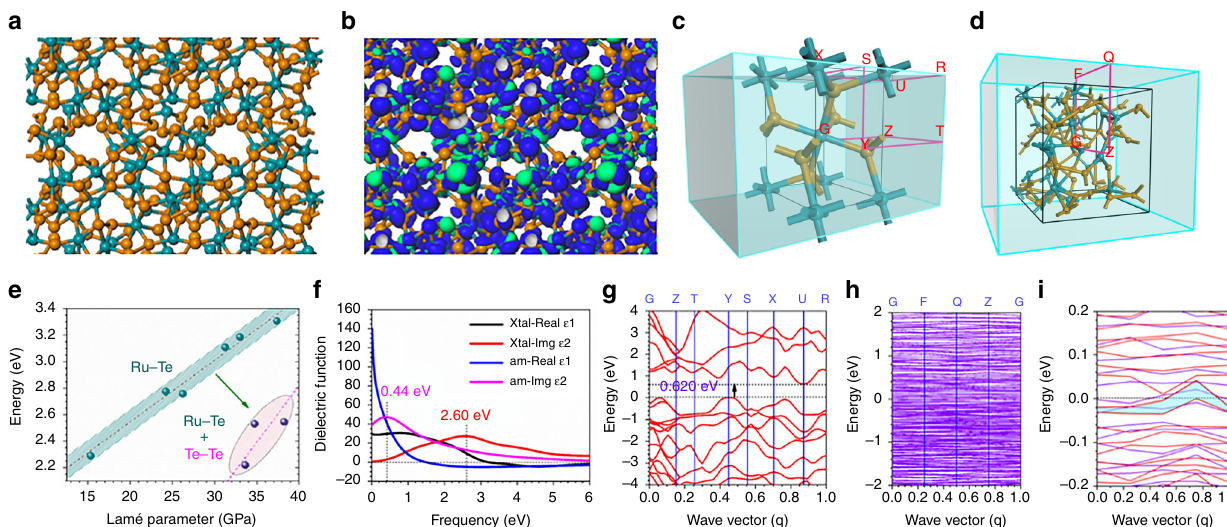
Fig. 1 Electronic structures comparison between the crystalline and amorphous RuTe 2 . a Local atomic con fi gurations for the amorphous RuTe 2 . b The real spatial contour plots for bonding and anti-bonding orbitals near E F . c The Brillouin zone of the crystalline RuTe 2 , in which the G, Z, T, Y, S, X, U, and R denote high-symmetry points within the reciprocal space (red). d The Brillouin zone of the amorphous RuTe 2 , in which the G, F, Q, and Z denote high- symmetry points within the reciprocal space (red). e Structural formation energy variation trend with related to the Lamé parameters for describing the bulk lattice distortion induced strain effect, as well as the Te-Te bond formation. f The dielectric function comparison. g The band structure of the crystalline RuTe 2 and h the amorphous RuTe 2 . i Enlarged display of the amorphous RuTe 2 band structure.